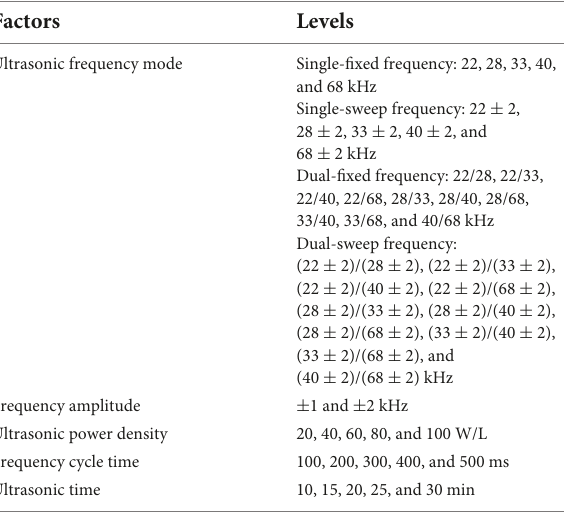
TABLE 1 Levels of ultrasonic frequency mode, ultrasonic power density, frequency amplitude, frequency cycle time, and ultrasonic time in the single-factor